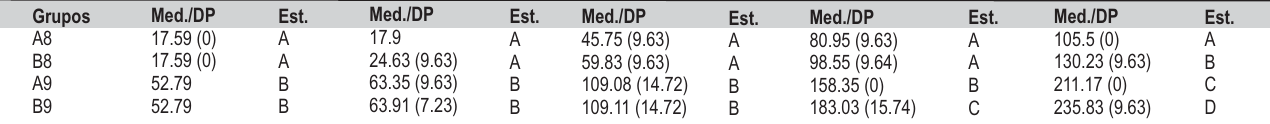
Table 1 . Means and standard deviations of forces (gf) generated by the bars according to the deformation (mm).